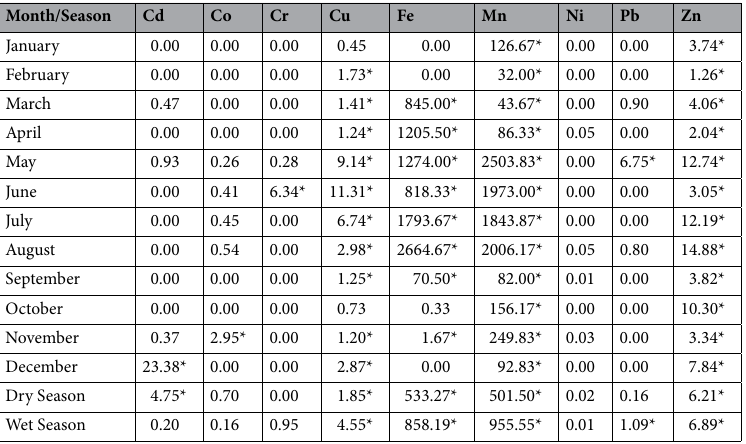
Table 2. Ecological Risk Quotient of Heavy Metals in O. niloticus in Agodi Reservoir. ERQ values with asterisk ‘*’ are above the ecological risk limit. (Source: Field